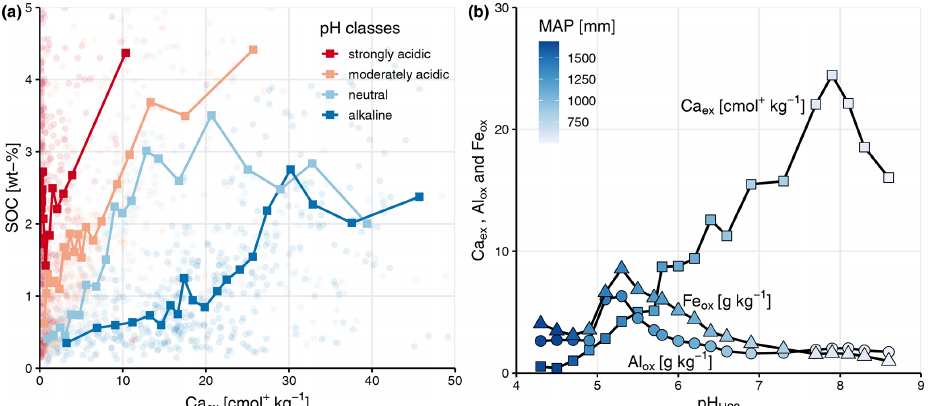
Figure 5. (a) Soil organic carbon (SOC) (wt%) and exchangeable Ca (Ca ex ; centimoles per kilogram) content colored by pH classes (3.9– 5.2 pH – strongly acidic; 5.2–6.1 – moderately acidic; 6.1–7.5 – neutral; 7.5–9.9 – alkaline) with binned averages (bold squares; n = 20). Note that the x axis is truncated for improved visualization, which removes three data points (Ca ex = 53 . 91, 54.58 and 75.66cmol + kg − 1 ). (b) Al ox , Fe ox (grams per kilogram; which were combined to M ox , i.e., Al ox + 1 / 2Fe ox , for the linear mixed effects models) and Ca ex (centimoles per kilogram) averaged content ( n = 20) across pH H and mean annual precipitation (MAP; millimeters). 2 O